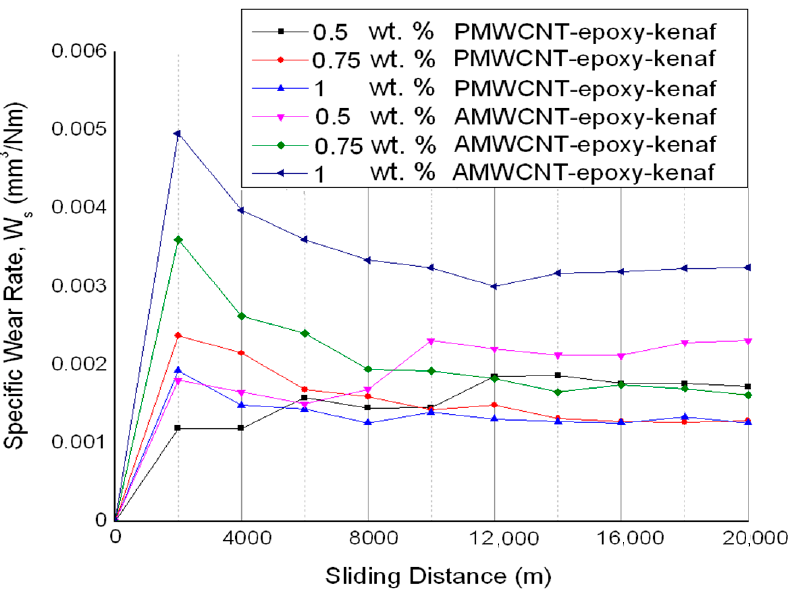
Figure 5. Specific wear rates of PMWCNT- and acid-treated MWCNT (AMWCNT)-filled epoxy– kenaf